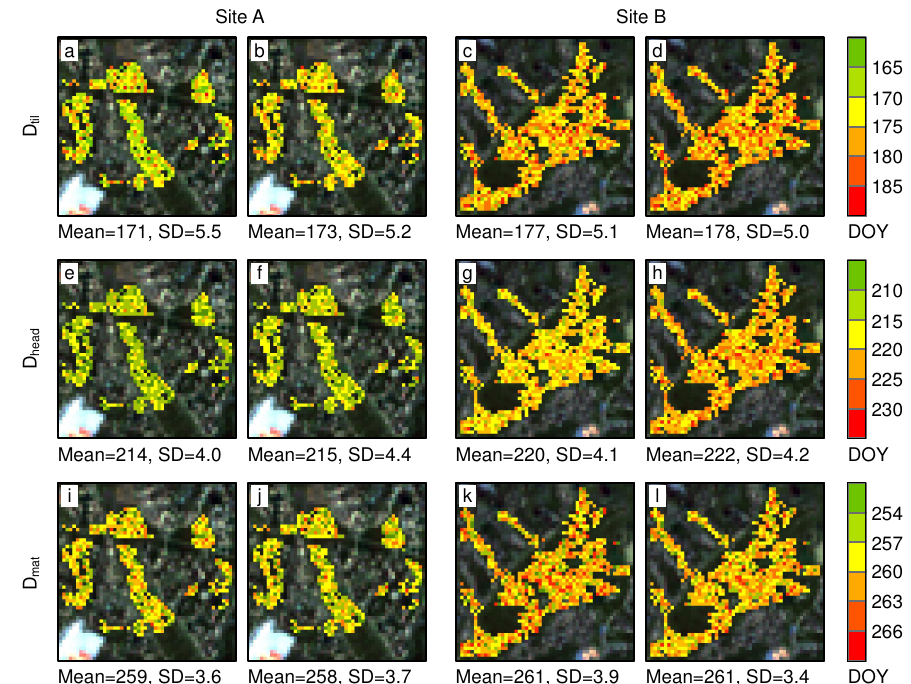
Figure 6. Spatial distributions of the mean dates of active tillering ( D til ) ( a – d ), middle heading ( D head ) ( e – h ), and maturity ( D mat ) ( i – l ) for Sites A and B during the period 2013–2017. Each of the phenometrics was derived from NDVI ( a , c , e , g , i , k ) and phase–space ( b , d , f , h , j , l ).